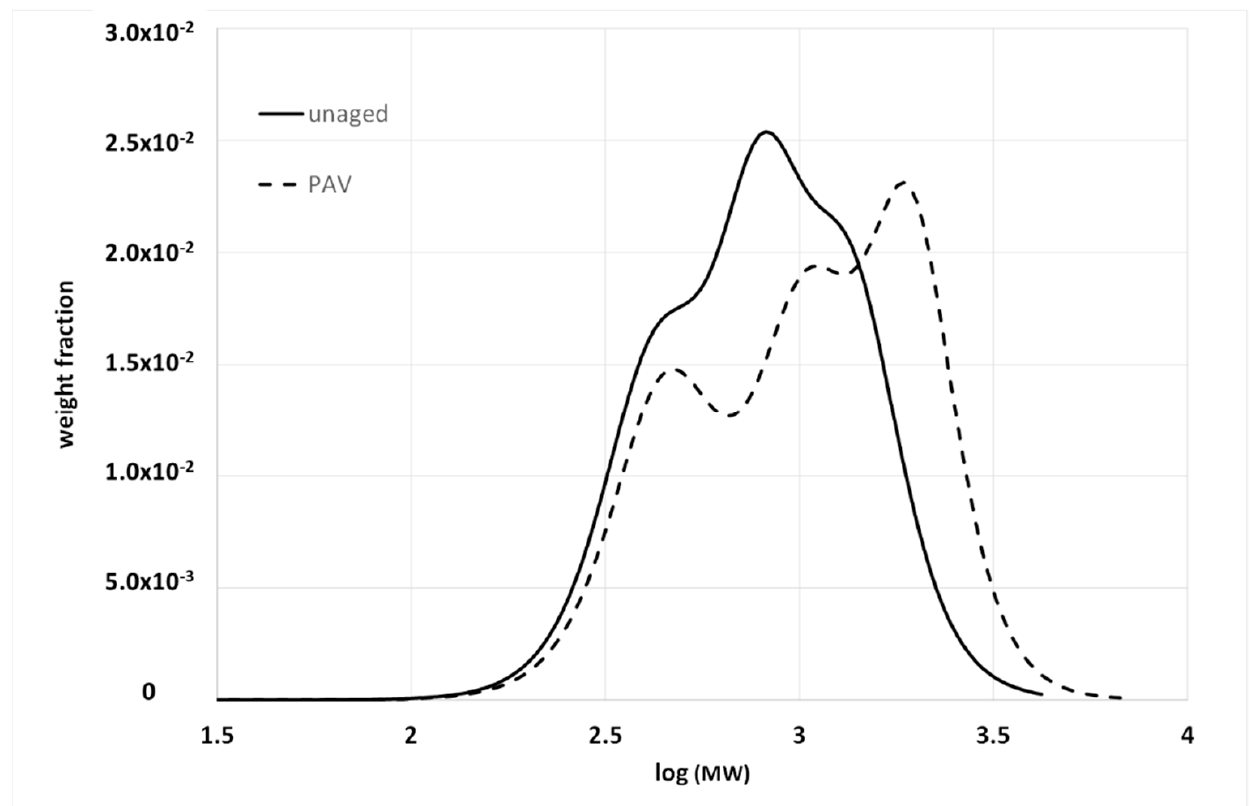
Figure 7. BMWD for a 35/50 Pen-grade base bitumen before and after PAV. All details are given in [33].